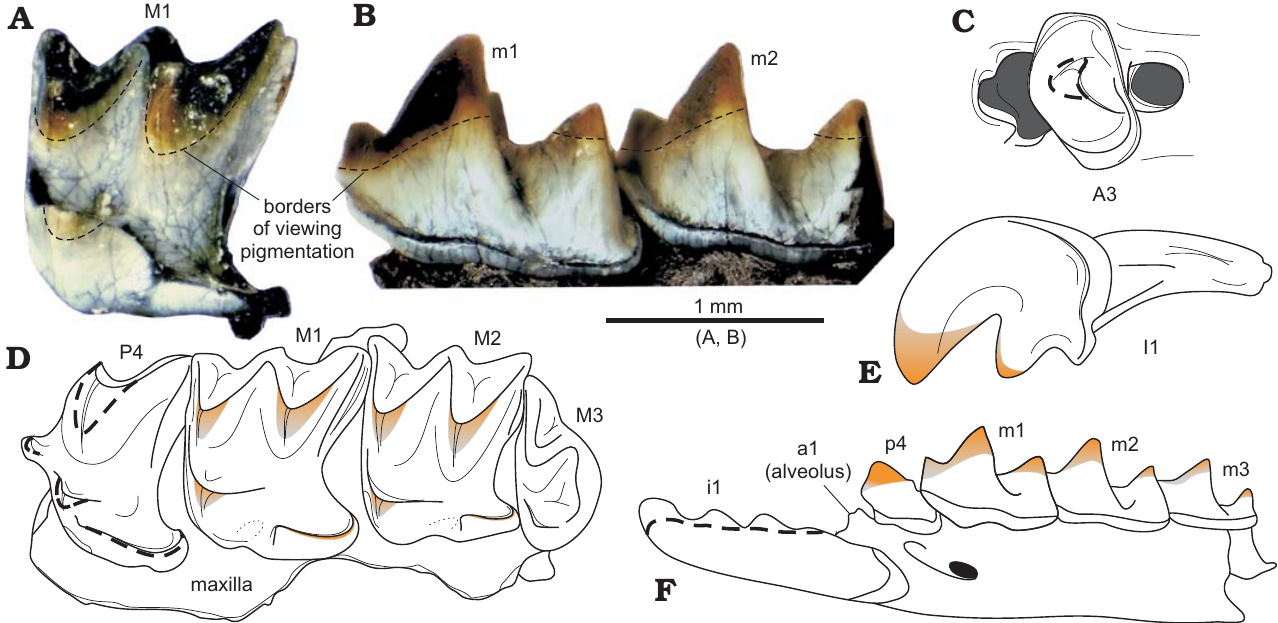
Fig. 6. Tooth pigmentation of crocidosoricine shrew Shargainosorex angustirostris gen. et sp. nov. from middle Miocene Sharga 2 locality, Mongolia. A . ZISP 104324/1080 (paratype), right M1 (mirrored), with pigmentation of main cusps, in occlusal view. B . ZISP 104325/1121, right dentary fragment (mirrored) in buccal view. C .ZISP 104324/1069 (paratype), right A3 in occlusal view. D . ZISP 104324/1055 (paratype), left maxilla in occlusal view. E . ZISP 104324/1068 (paratype), right I1 (mirrored) in buccal view. F . ZISP 104323 (holotype), left dentary fragment in buccal view. Dashed lines (C, D, F) indicate supposed pigment parts. Optical photographs (A, B), diagrammatic reconstructions of teeth coloration (C–F). C–F not to